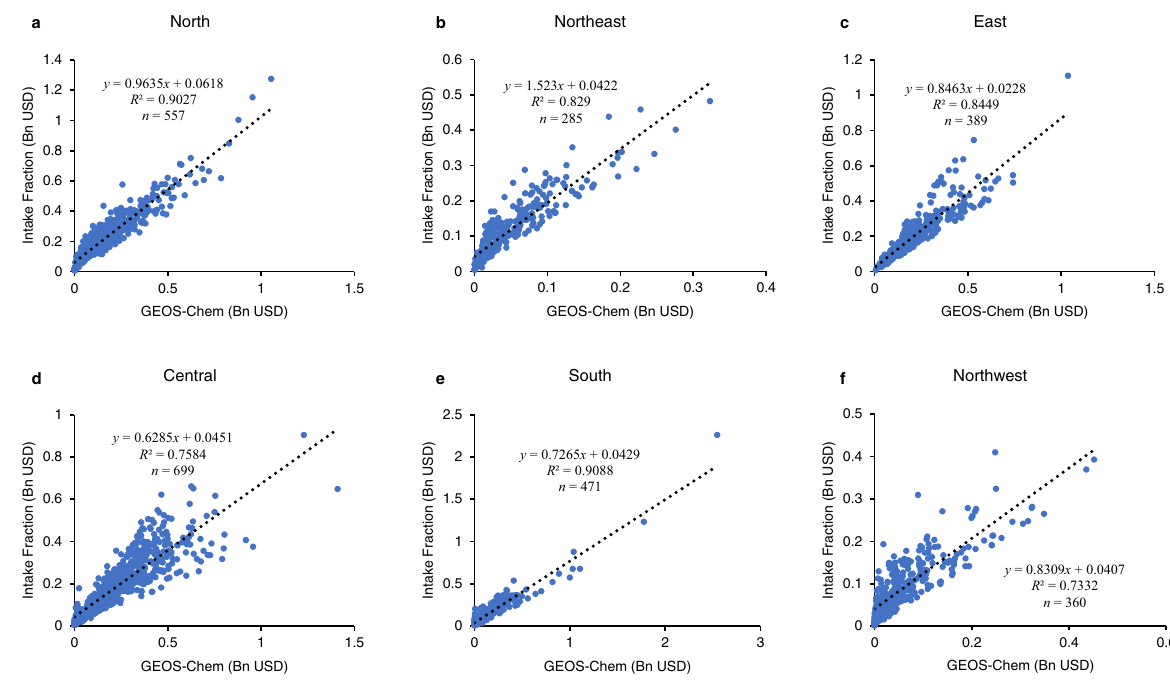
Fig. 7 Linear regressions between results based on intake fractions model and GEOS-Chem model. We calculate health losses suffered by each of the 2761 Chinese county-level districts according to the two models, and run linear regressions for counties within each of the six regional power grids. a – f present the results in six regional power grids,